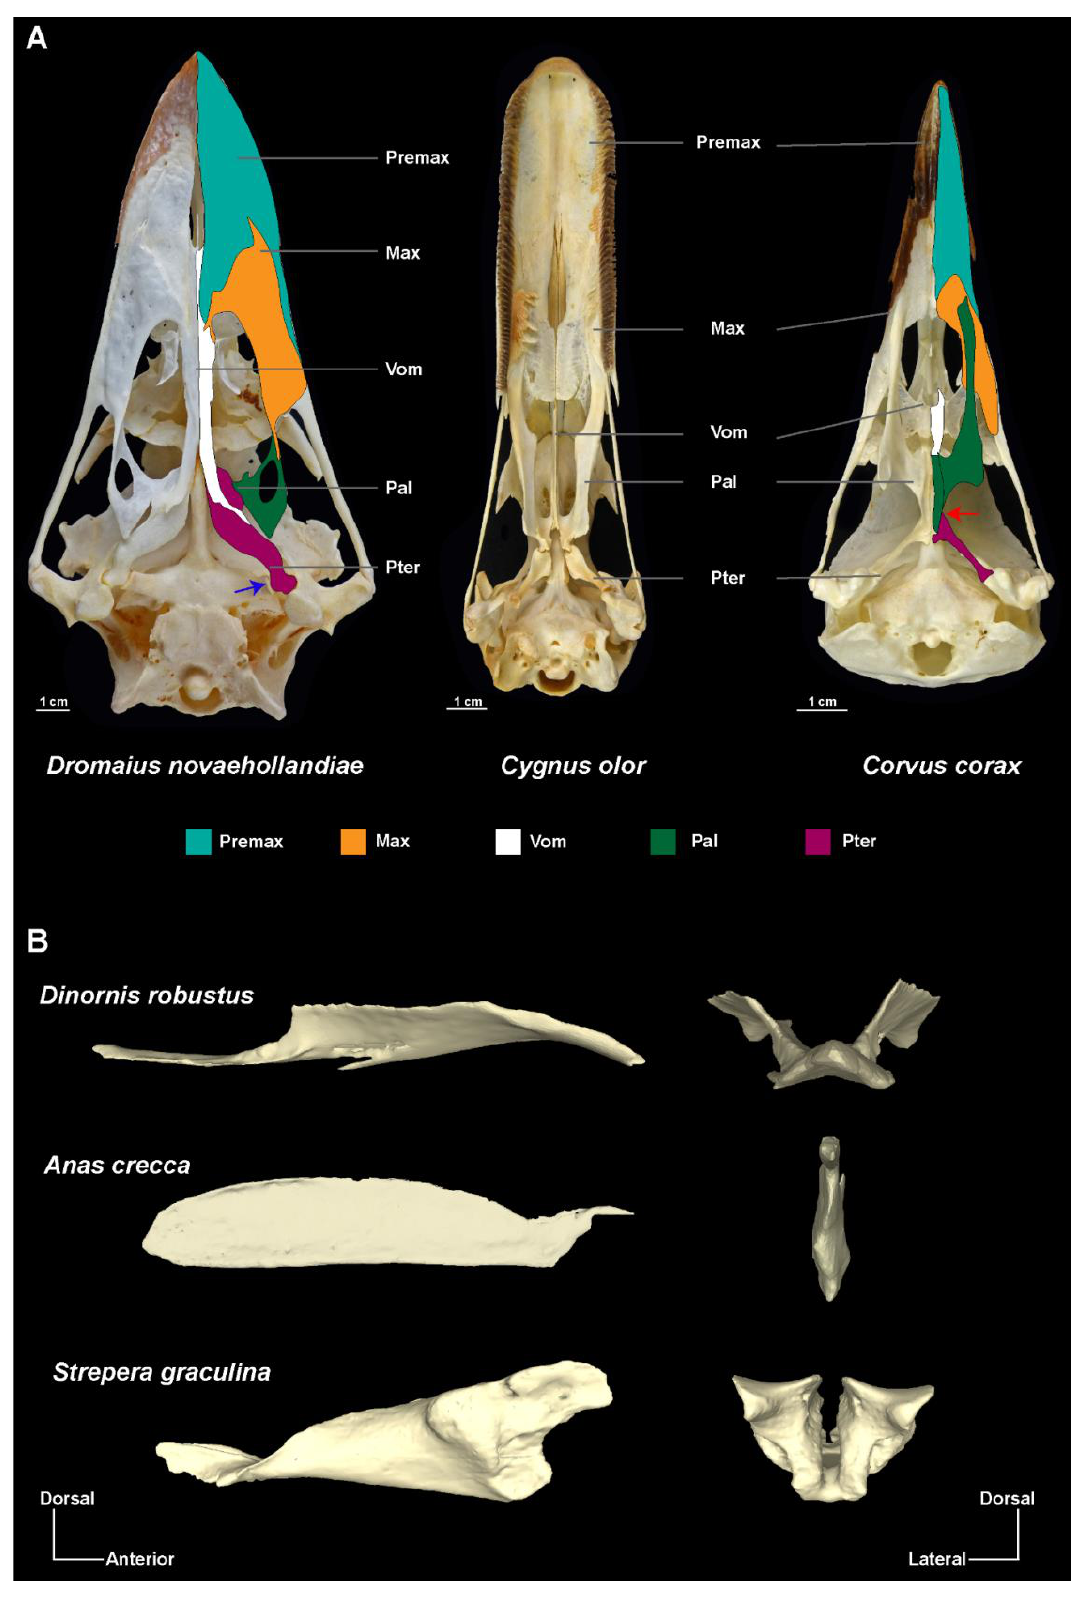
Figure 1. Anatomical organization of the pterygoid-palatine complex (PPC) and shape variability of the vomer in palaeognath and neognath birds. (A) Palates of Dromaius novaehollandia (left), Cygnus olor (middle) and Corvus corax (right) in ventral view (all specimens form the Natural History Museum of Fribourg/University of Fribourg). For Dromaius novaehollandiae and Corvus corax the main